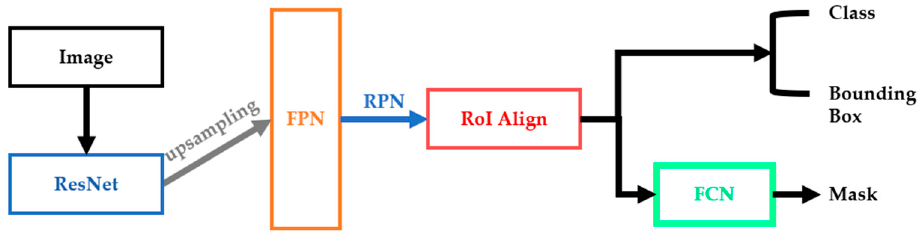
Figure 2. The structure of Mask R-CNN.